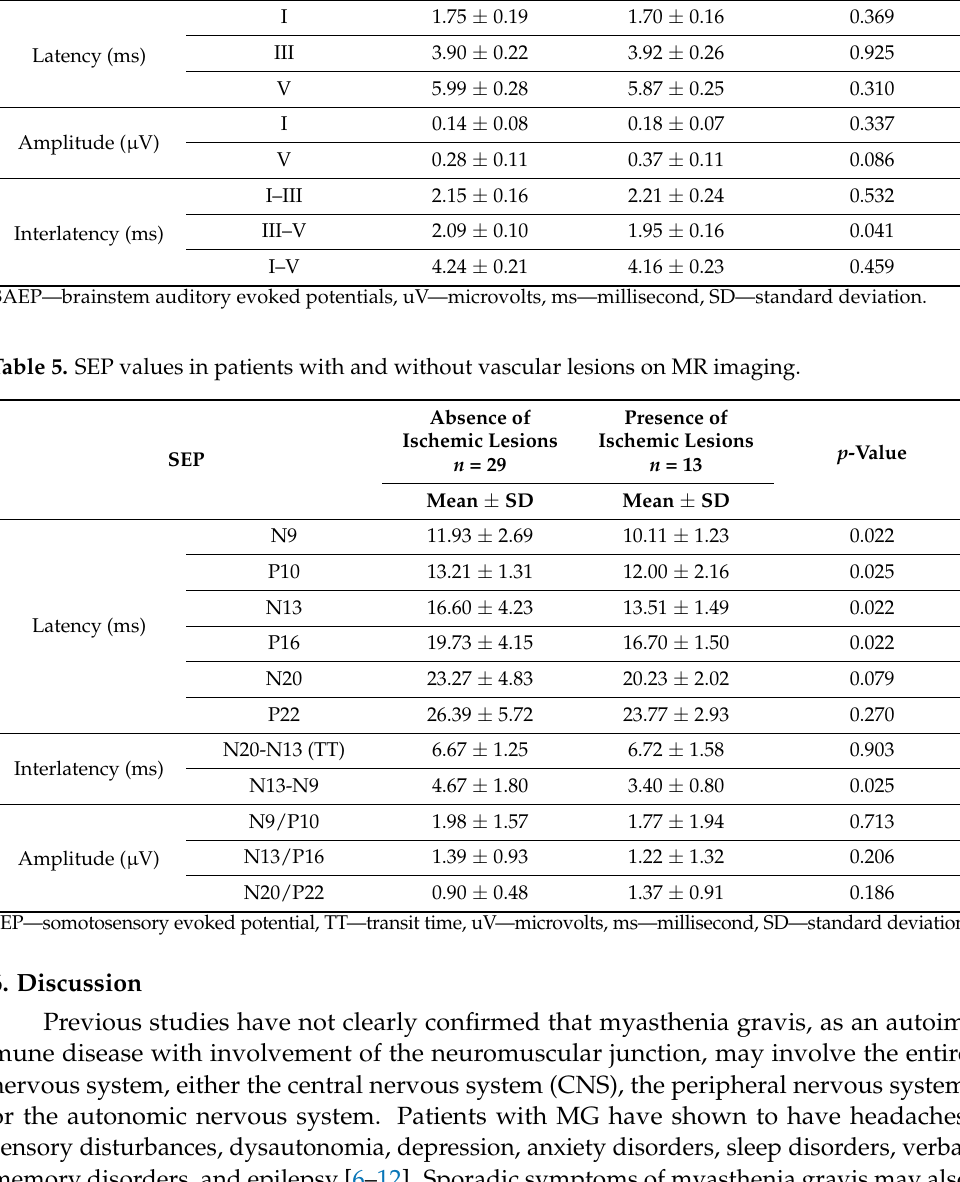
Table 4. BAEP values in patients with and without vascular lesions on MR imaging.